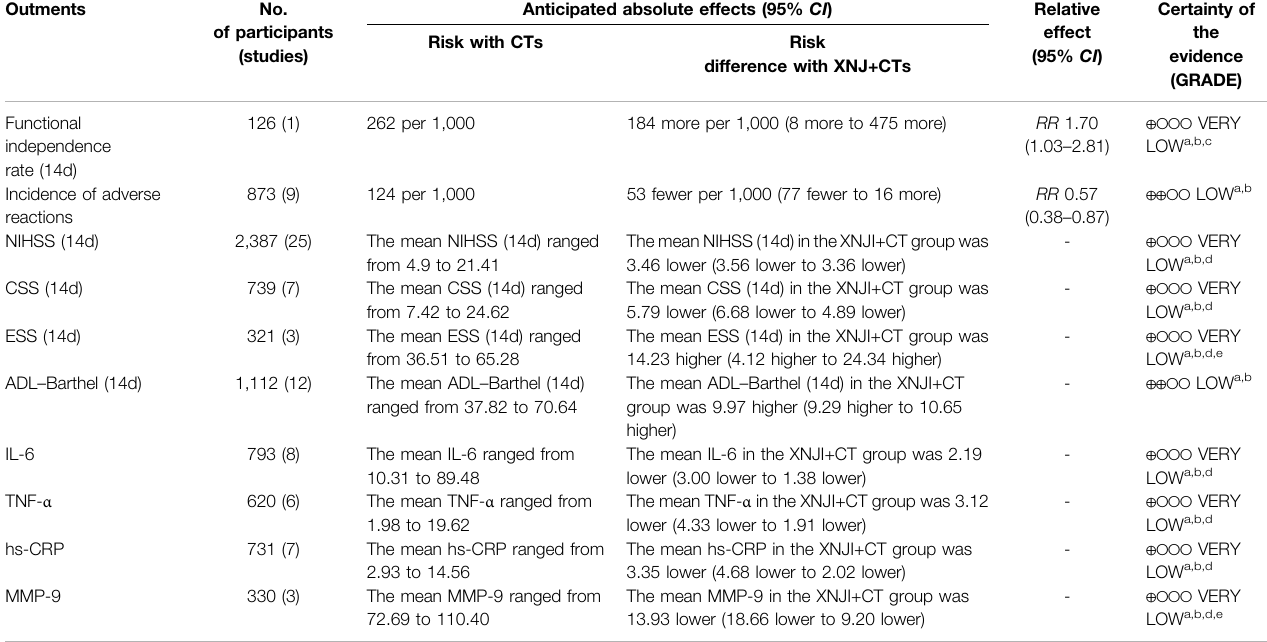
TABLE 2 | GRADE summary of outcomes for XNJ+CTs versus CTs for patients with AIS.